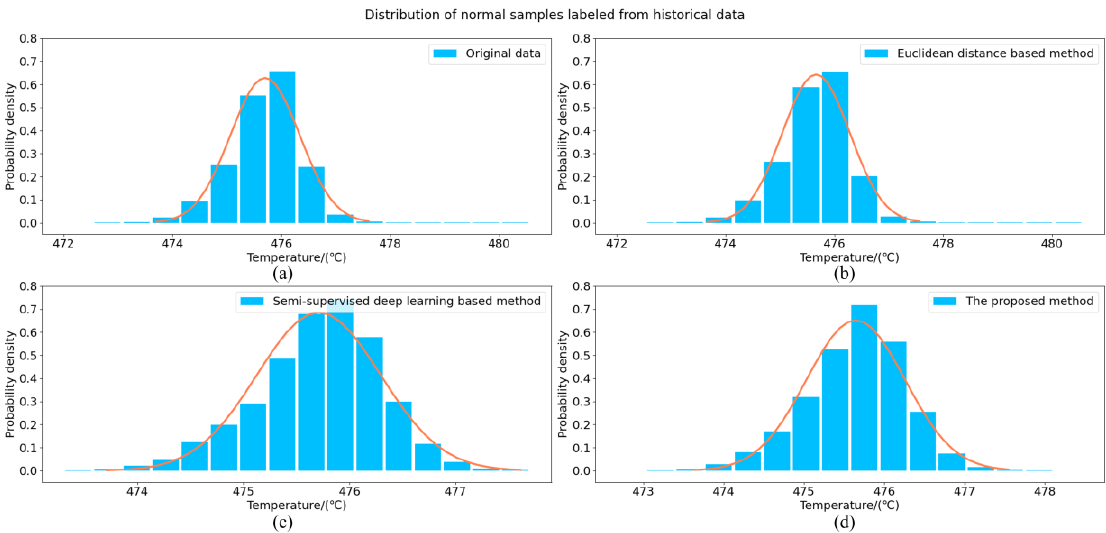
Figure 6. Comparison results on the data labeling performance of different methods: (a) original data; (b) Euclidean distance-based method; (c)semi-supervised deep learning-based method; (d) data; ( b ) Euclidean distance-based method; ( c ) semi-supervised deep learning-based method; ( d ) the the proposed method. proposed